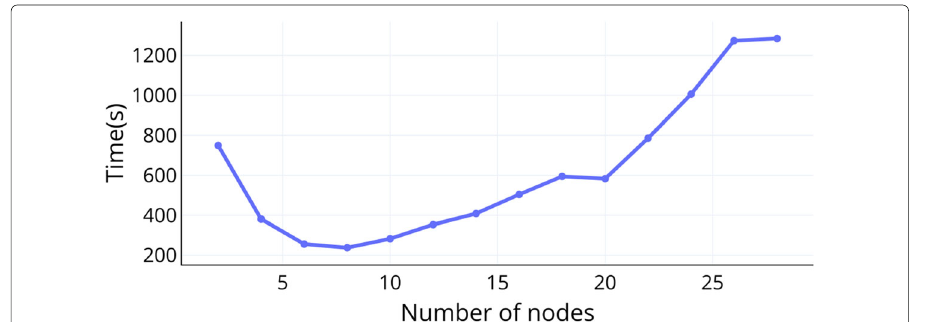
Fig. 4 Scaling properties of MethodFUI , for the MNIST data